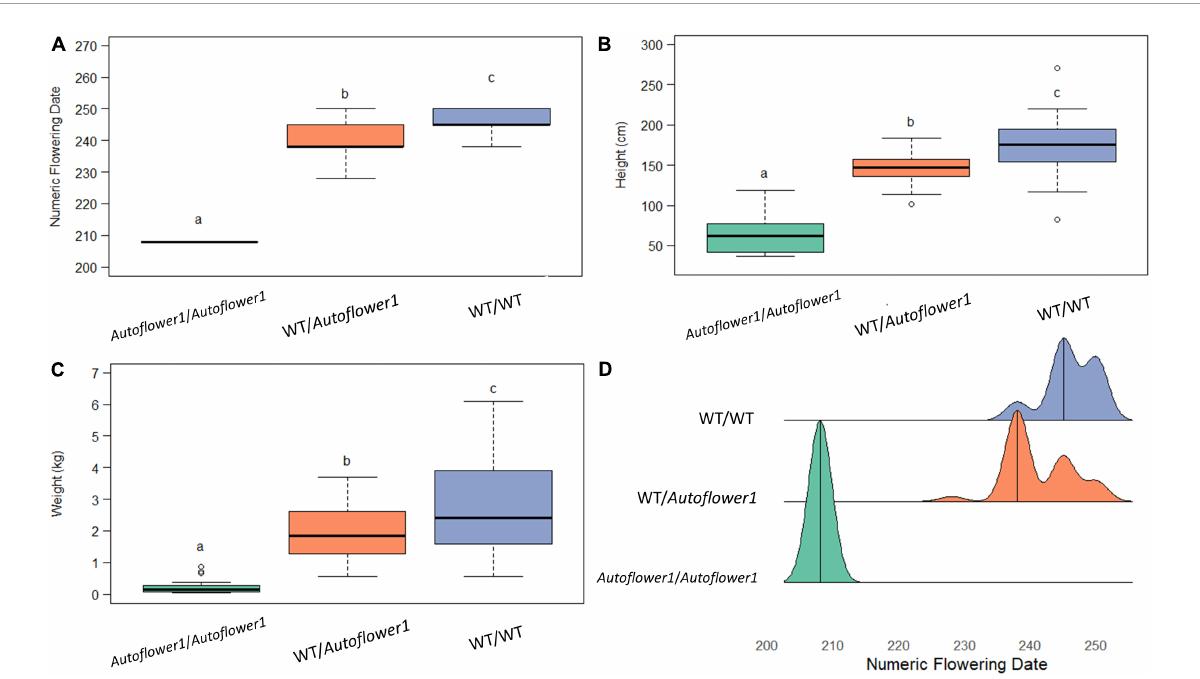
FIGURE2 Effect of genotype at Autoflower1 on agronomic traits. (A) Numeric (ordinal) flowering day. (B) Height, measured from base to tip at end of season. (C) Wet biomass. (D) Density ridge plot of flowering times within groups. Letters depict Tukey post-hoc test groupings ( α =